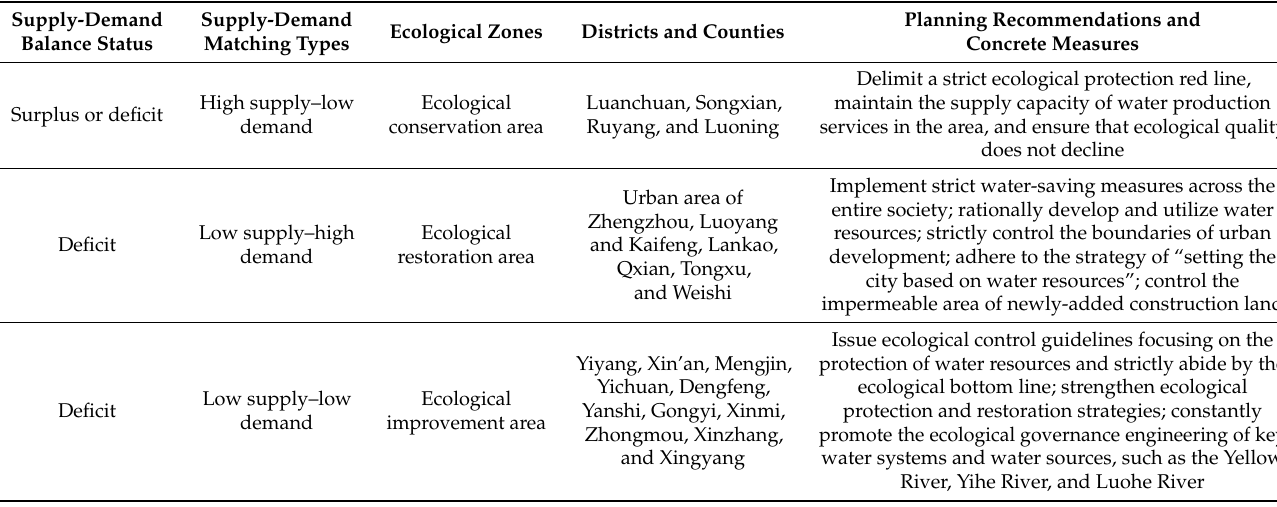
Table 5. Ecological subregions and planning